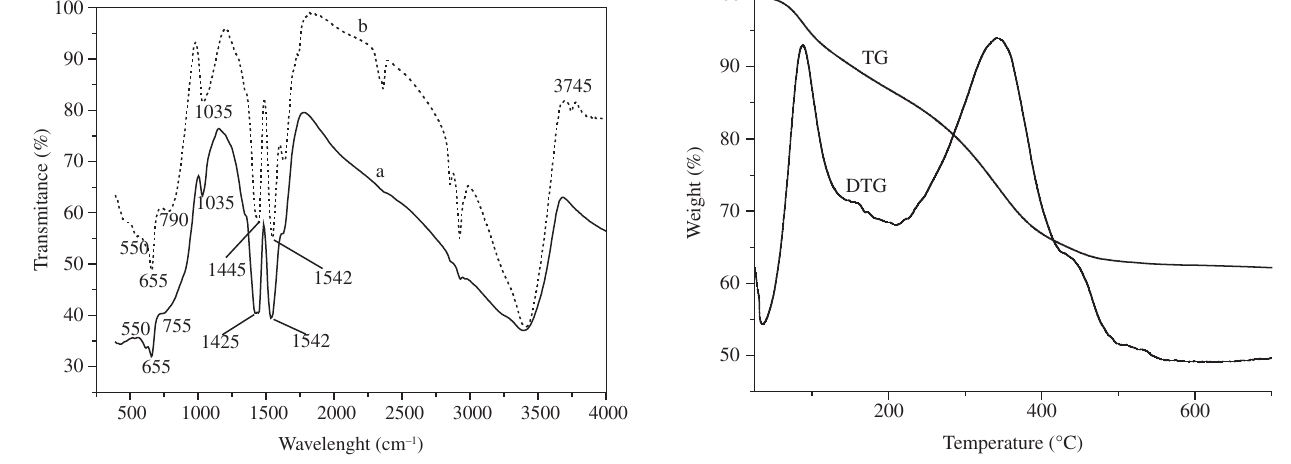
. Figure 6. TG curve and DTG of cyanidin-functionalized TiO 2